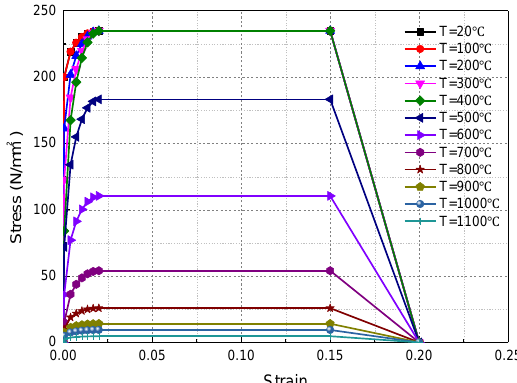
Figure 16. Stress-strain relationship model of steel at high temperatures prescribed in EC3.